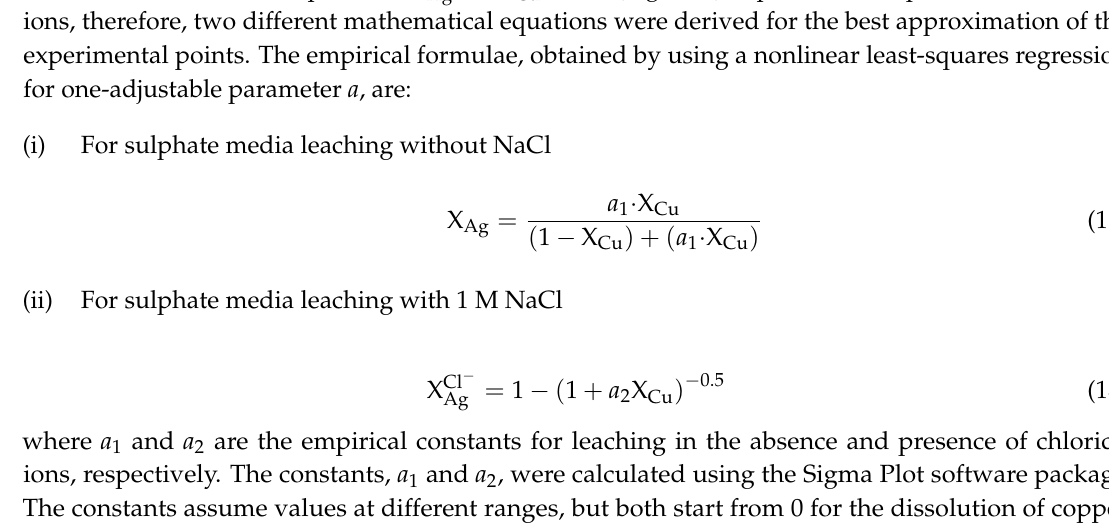
Figure 4. Dissolution of silver (X Ag ) vs. dissolution of copper (X Cu ) curve (80 °C, 1 M H 2 SO 4 , 13.5 g/dm 3 MnO 2 , 30 g/dm 3 SMS, 300 rpm, leaching time 24